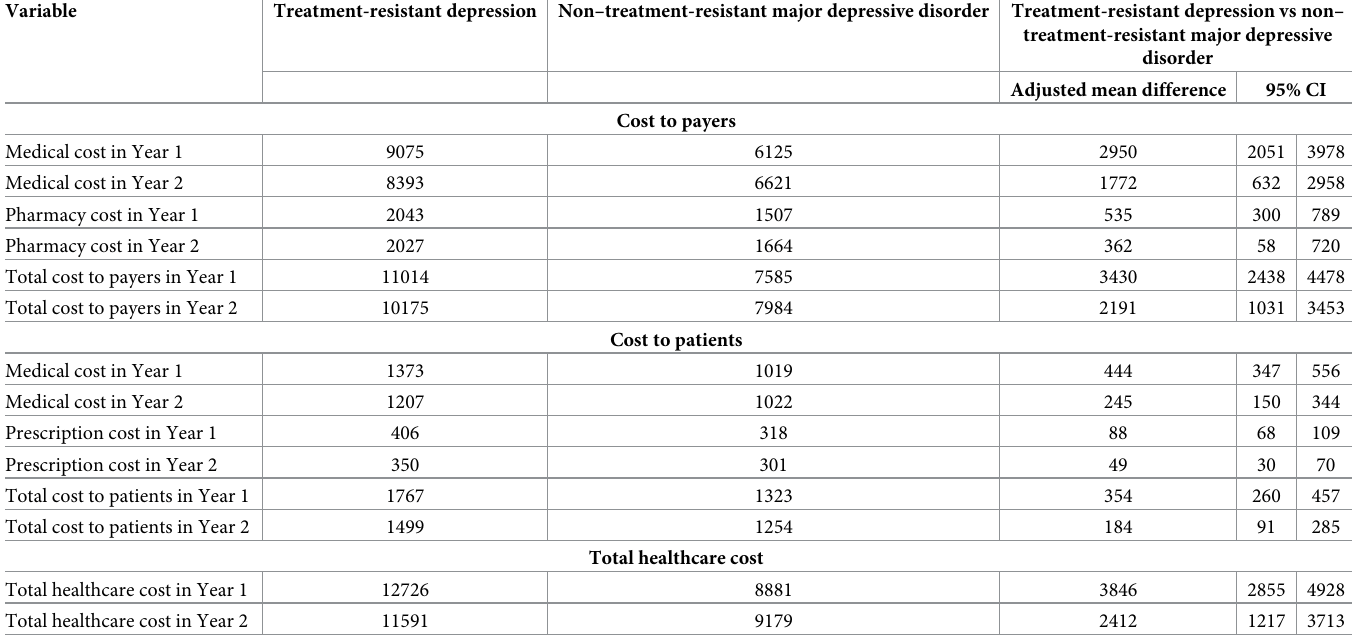
Table 3. Comparison of costs per year between treatment-resistant depression and non–treatment-resistant major depressive disorder patients (US$) a .